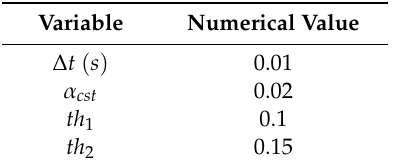
Table 1. Numerical constants used in the study.